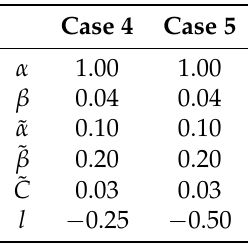
Figure 10. Survival Probabilities of Cases 4 ( a ) and 5 ( b ). Table 8. Parameters of the Extended Surrender